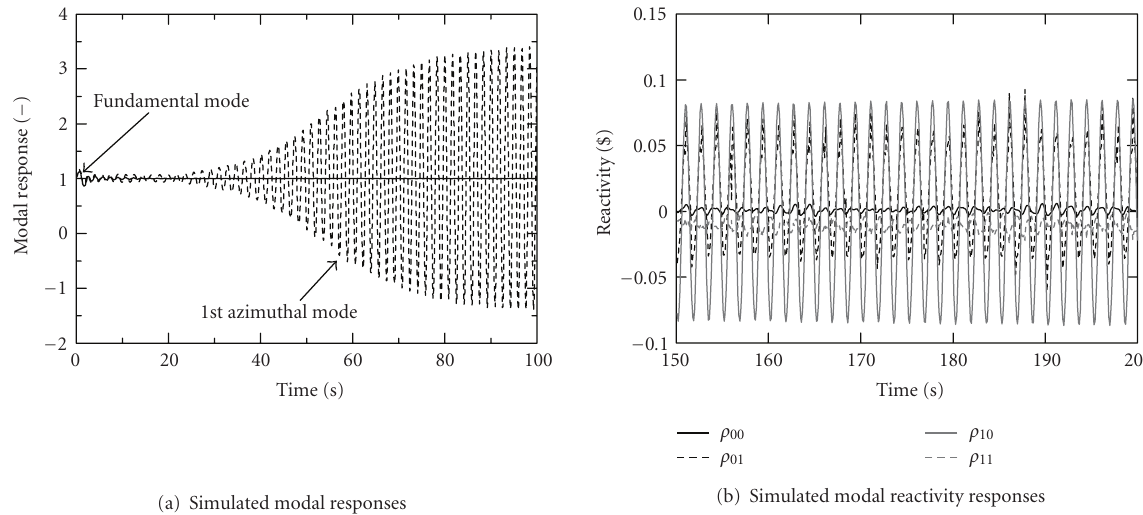
Figure 8: Modal parameter responses under simulated Ringhals-1 C14/PT9 regional